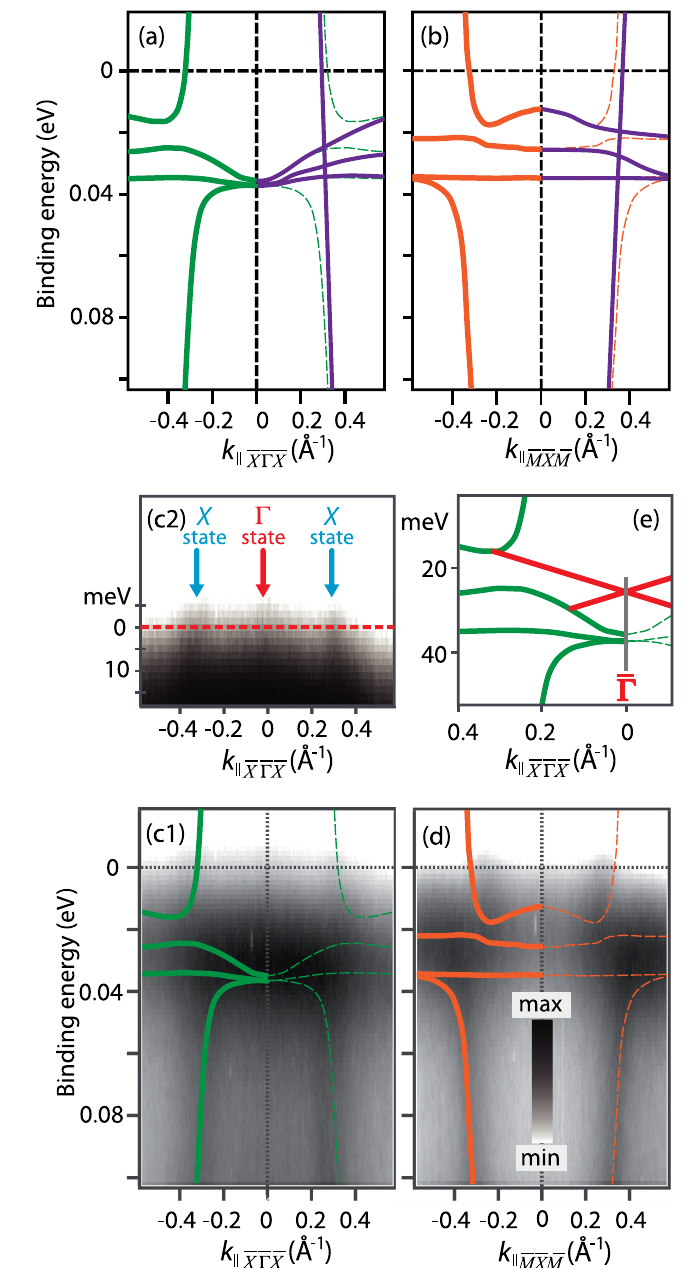
FIG. 4. k discontinuities, position of the chemical potential, and hybridization renormalization from comparison with bulk, ab initio theory. (a),(b) Solid lines in the left (right) parts illustrate hybridized (nonhybridized) d and f bands along two high-symmetry directions in k space. The lines are adaptations of the bulk LDA þ Gutzwiller theory data of Ref. [18]. The hybridized cases are overlaid as thin dashed lines in the right parts to aid identification of the hybridization gapping. (c1),(d) The same theory curves are now overlaid on the experimental band structure along X (cid:1) X and MXM ; k z ¼ 6 (cid:2)=a ( h(cid:1) ¼ 70 eV ). A very good match is obtained when the total bandwidth of the theoretical 4 f multiplet is renormalized by a factor of one-third compared to the original theory data [18], with a simultaneous rigid shift of the theoretical data 20 meV to higher binding energy, carried out to account for a difference in chemical potential between theory and experiment. This renormalization means the 5 d - 4 f hybridization gaps are only 5–10 meV. From (c1) and (d), it is clear that the X states, including the k discontinuity that is evident on comparing below and above the hybridization zone, are described very well by the energy-scaled bulk theory, removing them from the suspect lineup as far as topological surface states go. In contrast, the (cid:1) states, which are highlighted in the zoomed portion of the X (cid:1) X data in (c2), are missing in the bulk theory. The absence of (cid:1) states in bulk calculations is a signal of their promise in terms of identifying potential topological (cid:2)(cid:1) surface states in future ultrahigh-resolution ARPES experiments. (e) A zoom of the theory around , together with a sketch of a (cid:2)(cid:1) massless Dirac cone centered at the point as a guide for future